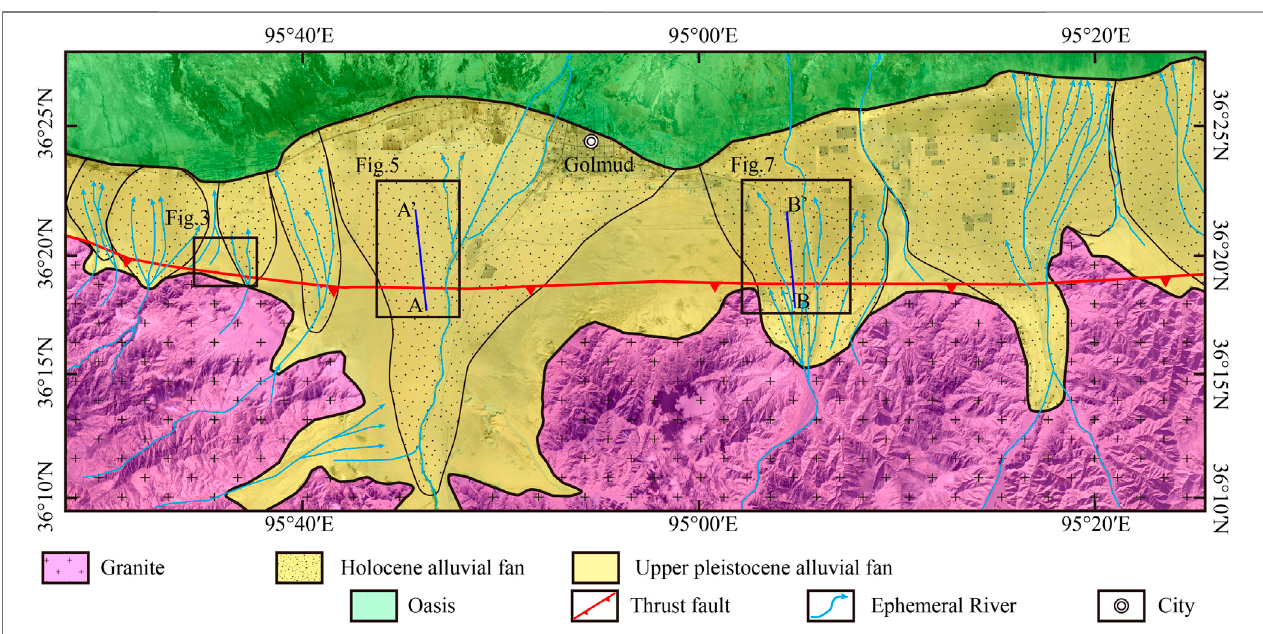
FIGURE2| InterpretationofAlluvialfansinfrontoftheKunlunrange.Theblackboxesindicatethelocationsofthefollowing fi gures.Bluelineindicatethelocationsof the Shallow Seismic Pro fi le.